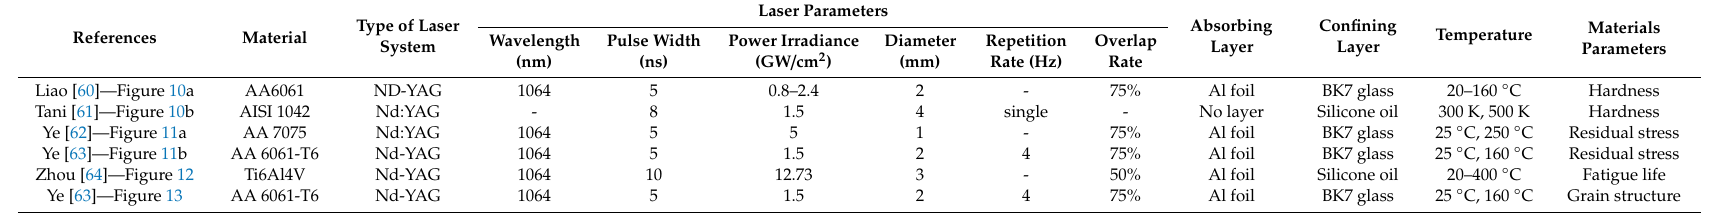
Table 1. Main experiment parameters of LSP and WLSP provided by selected references reports in Section